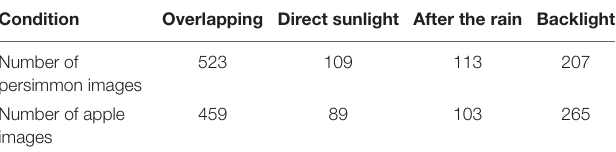
TABLE 1 | Sample distribution details of green fruit images.